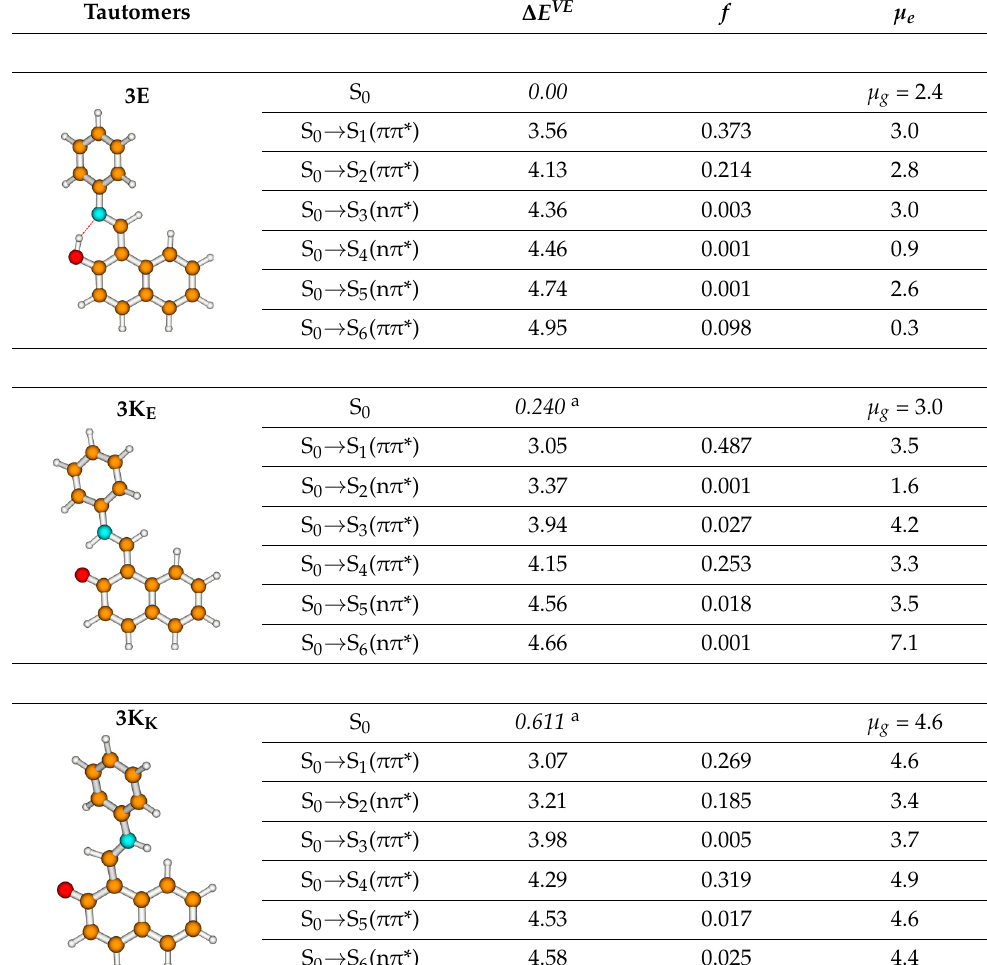
Table 2. Vertical excitation energy, Δ E VE (in eV), oscillator strength, f , and dipole moment, μ e ( in Debye), of the lowest excited singlet states calculated with the CC2/aug-cc-pVDZ method for the ground state equilibrium forms of 3 , optimized at the MP2/cc-pVDZ theory level. The dipole moment of the ground-state, μ g (in Debye, MP2/cc-pVDZ).